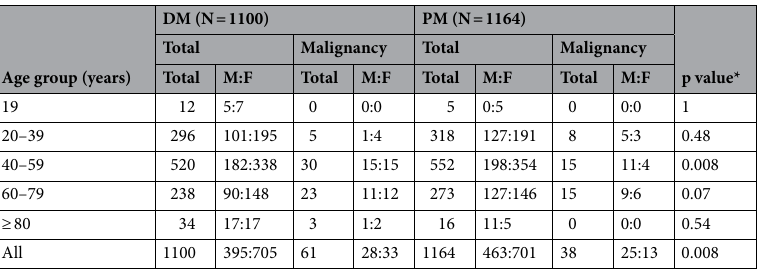
Table 1. Total and malignancy cases of DM and PM in the study population (2001–2019 May), by age and gender group. DM dermatomyositis, PM polymyositis, M male, F female; *p value: Chi-square or Fisher exact test between total DM and PM with or without malignancy.